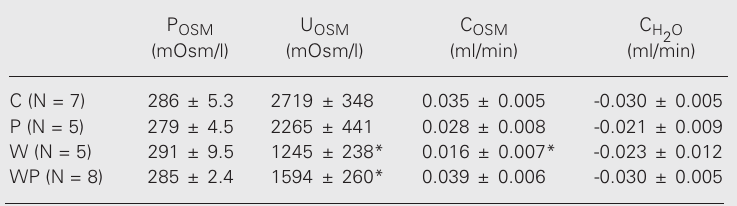
Figure 2. Fractional sodium ex- cretion (FE Na+ ) of control rats (C, N = 7), control rats supple- mented with fish oil-n-3 PUFA (P, N = 5), Walker 256 tumor- bearing rats (W, N = 5), and W supplemented with fish oil rats (WP, N = 8). Data are reported as means ± SEM. Note that the W group has a significant de- crease in FE Na+ compared to control (P < 0.05, ANOVA, fol- lowed by the Student-Newman- Keuls contrast